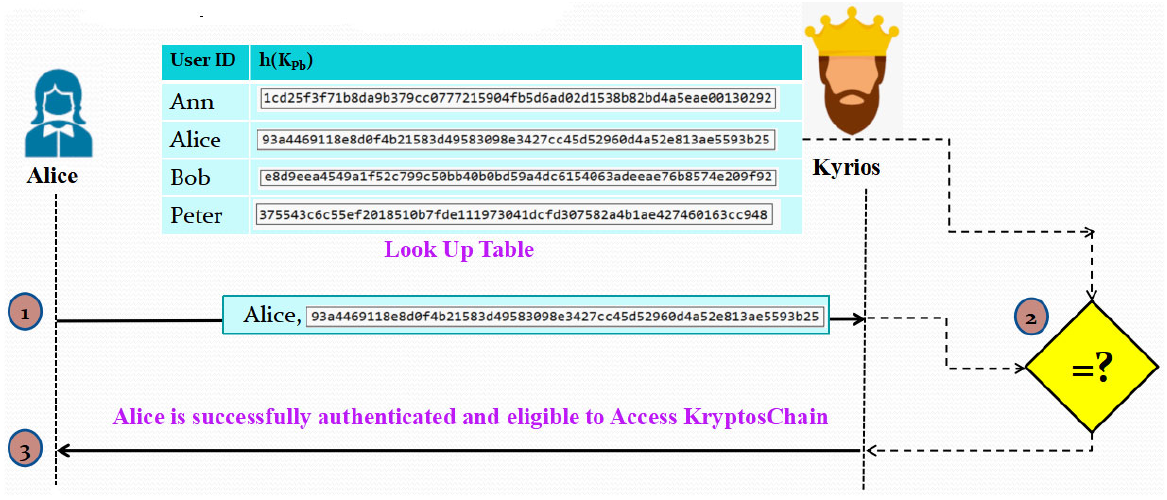
Figure 12. Demonstration of Phase 2: Sender Authentication.